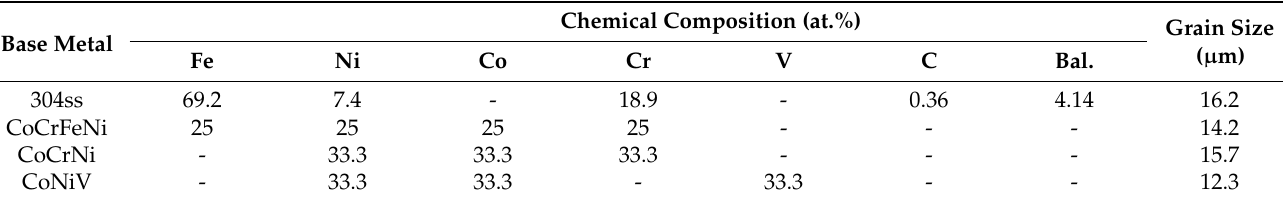
Table 1. Chemical composition and grain size of the base